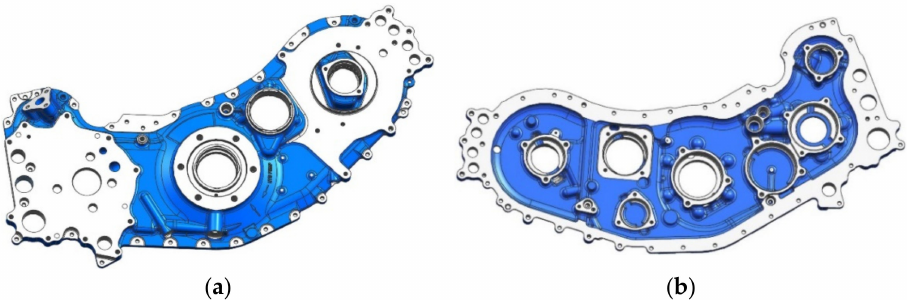
Figure 2. CAD model of an ADT casing cover: ( a ) exterior view; ( b ) interior view (from bearing